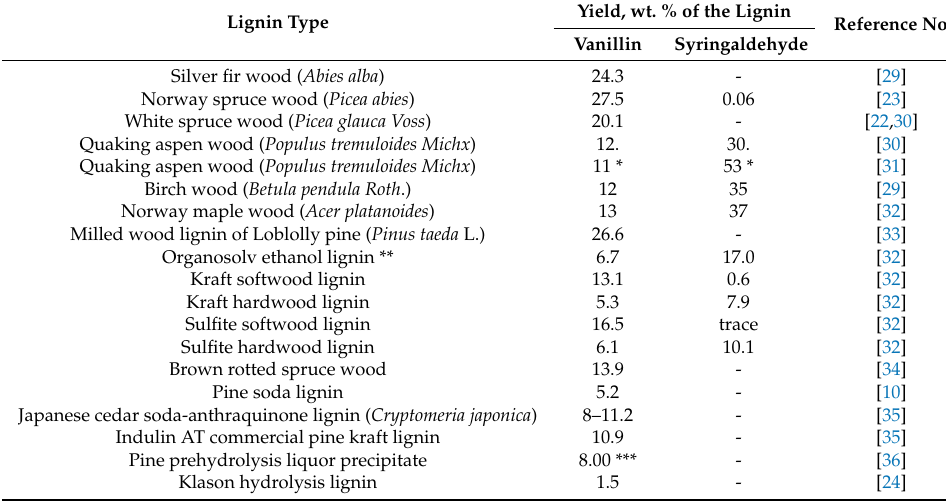
Table 1. Nitrobenzene oxidation of various lignins into the aromatic aldehydes. Yield, wt. % of the Lignin Type